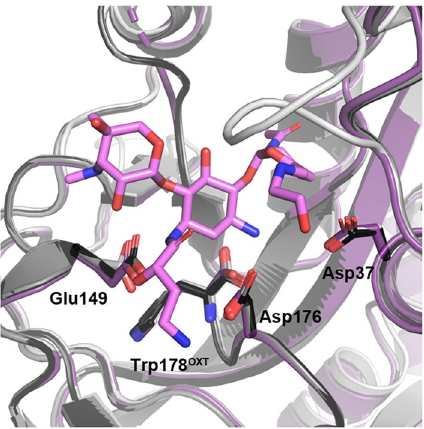
Figure 6. Active site overlay and conserved residues of AAC(2 ′ )-Ia and modeled enzymes. AAC(2 ′ )-Ia from P. stuartii is colored in purple, while the models are colored black ( D. sp. NW-56 ), grey ( D. wulumuqiensis ) and light grey ( M. arabiense ). Plazomicin is depicted in stick representation and colored in violet.